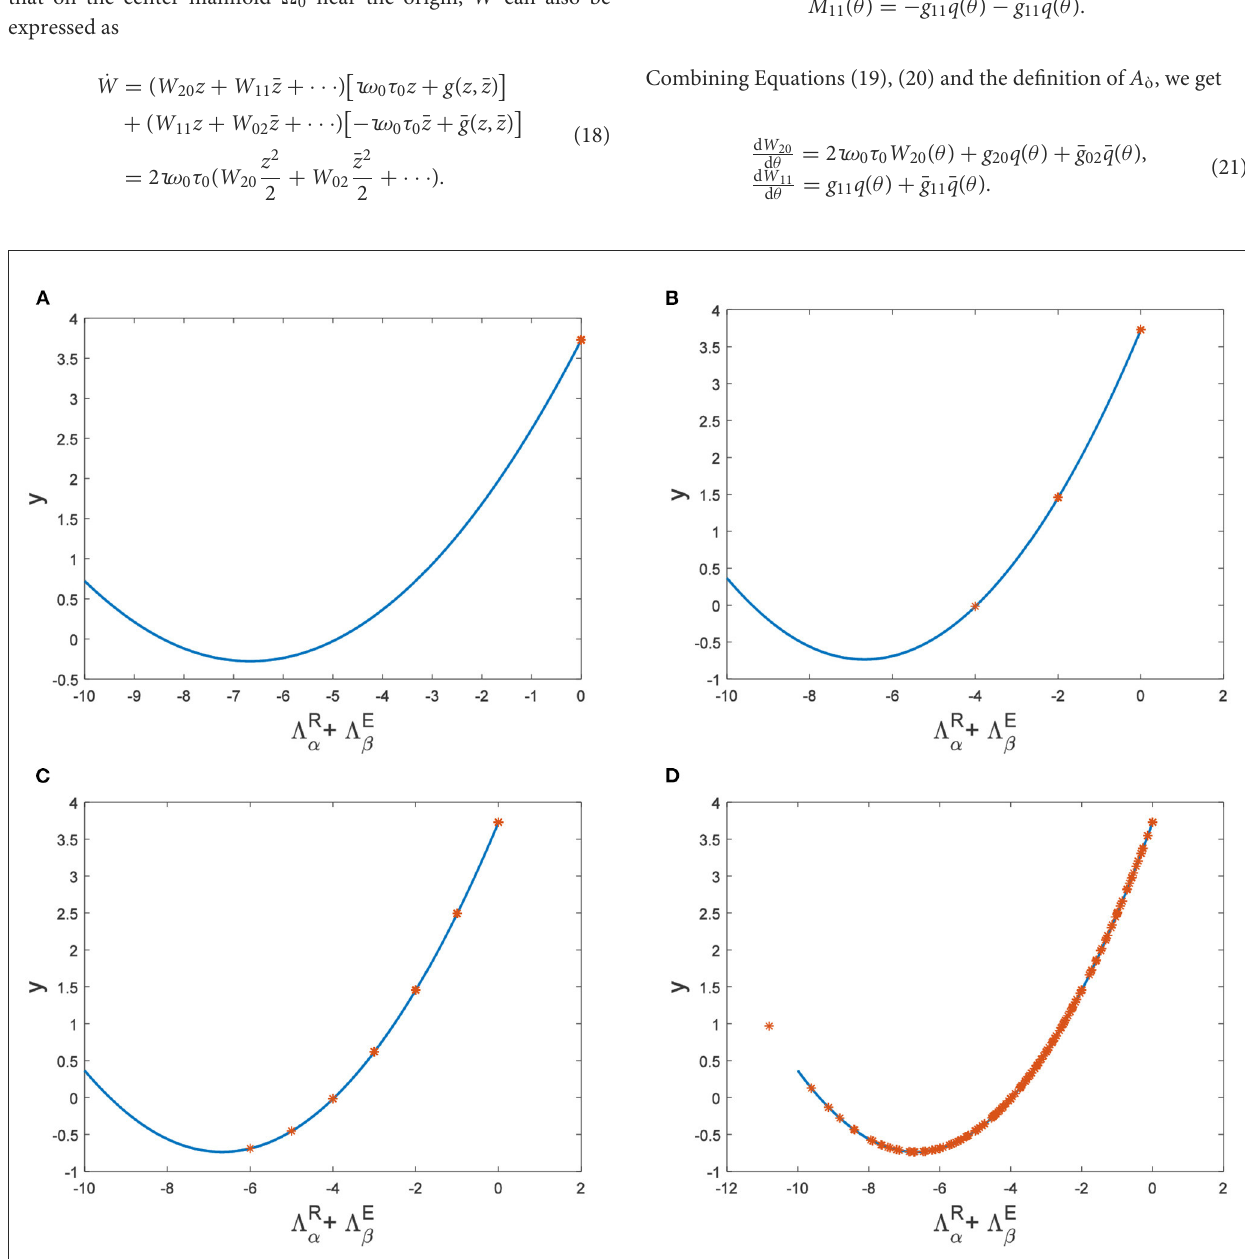
FIGURE4 The relationship between 3 R α D v 10, p =